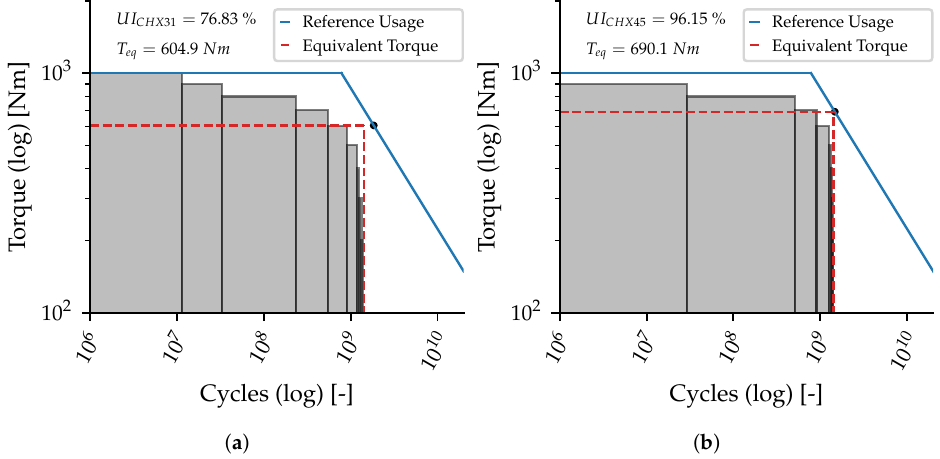
Figure 12. The result of the usage analysis summarized as summed torque collective with UI and T eq for (a) CHX31 and (b) CHX45 .